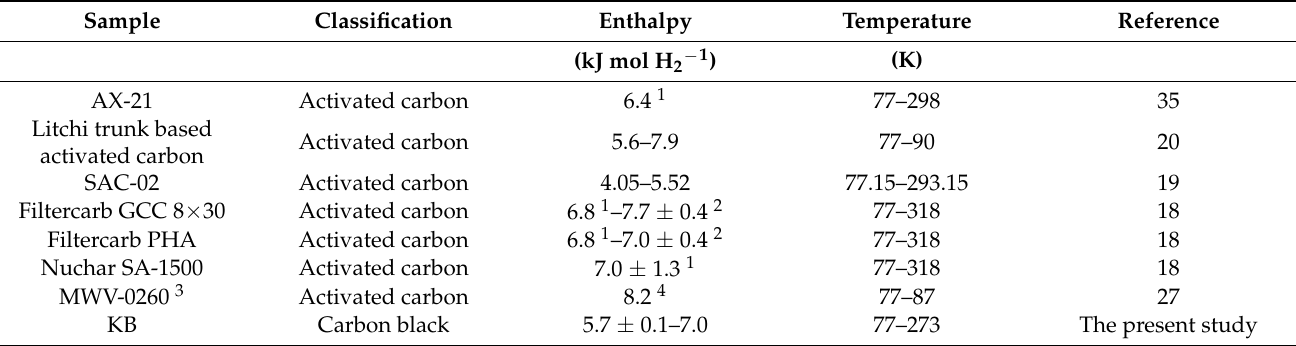
Table 2. Enthalpies of hydrogen adsorption on various amorphous